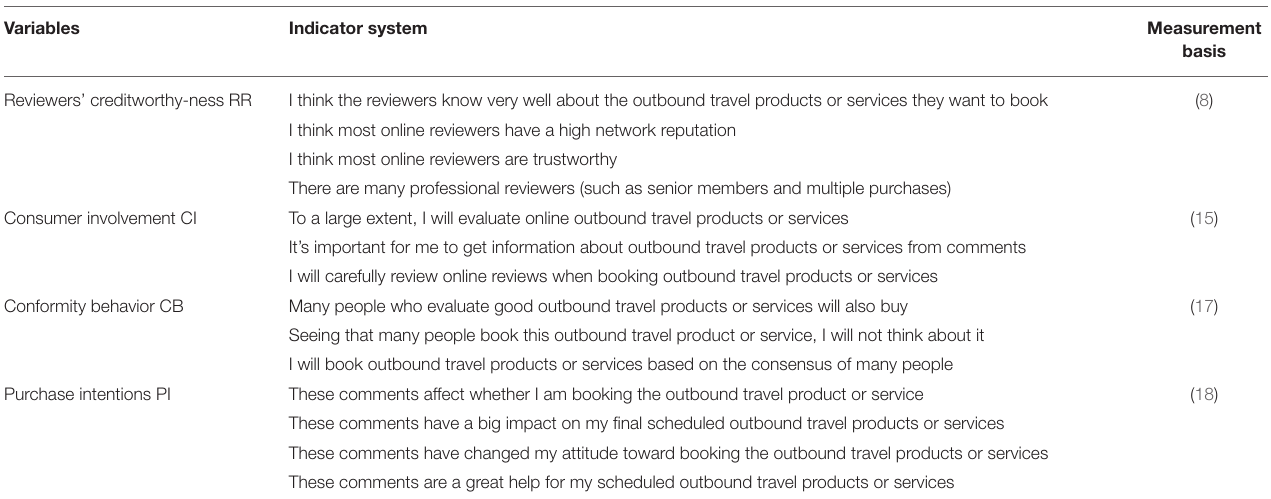
TABLE 1 | Study variable items and sources.